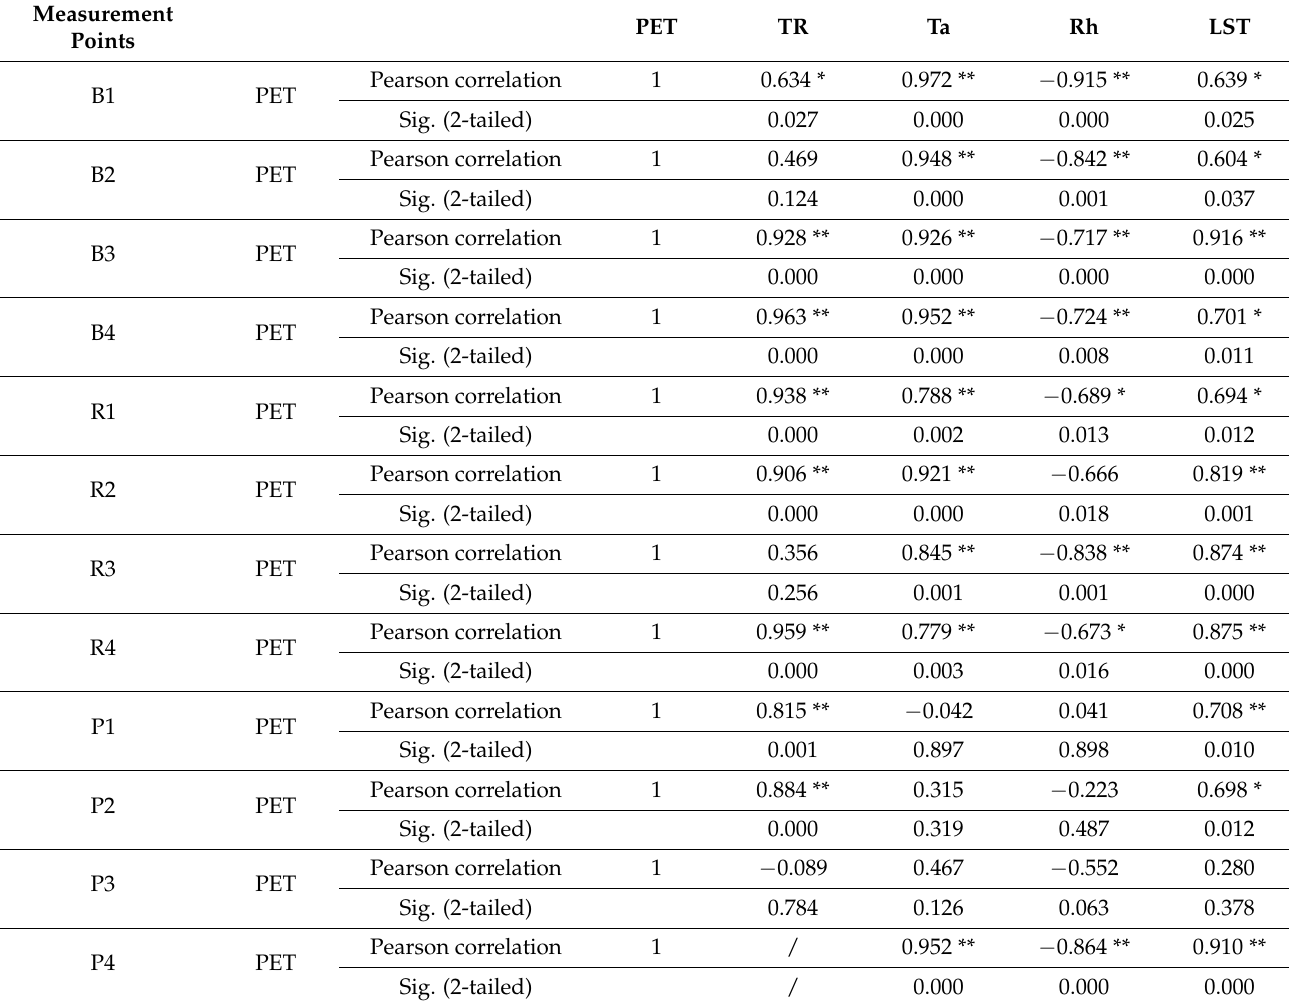
Table 3. Correlation analysis of PET and thermal environment factors at each measurement